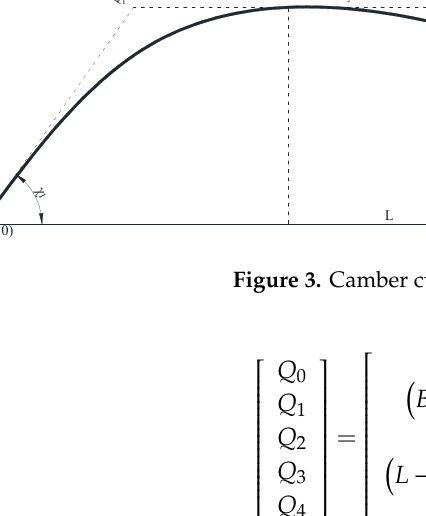
Figure 3. Camber curve parameterization.